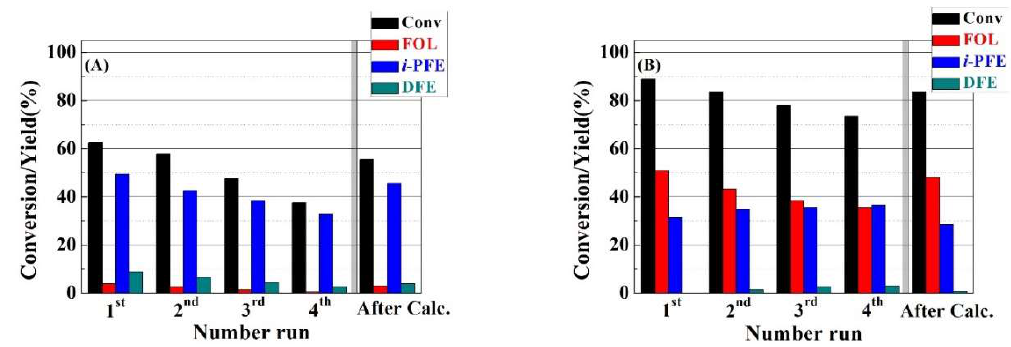
Figure 9. Furfural conversion, furfuryl alcohol yield, i -propyl furfuryl ether yield and difurfuryl ether yield for RT ( A ) and HT-TMB ( B ) catalysts. (Experimental conditions: 0.1 g of catalyst, temperature reaction: 130 °C, reaction time: 2 h, run number: 4, i -Pr-OH/FUR molar ratio: 50, FUR/Catalyst mass ratio: 1).